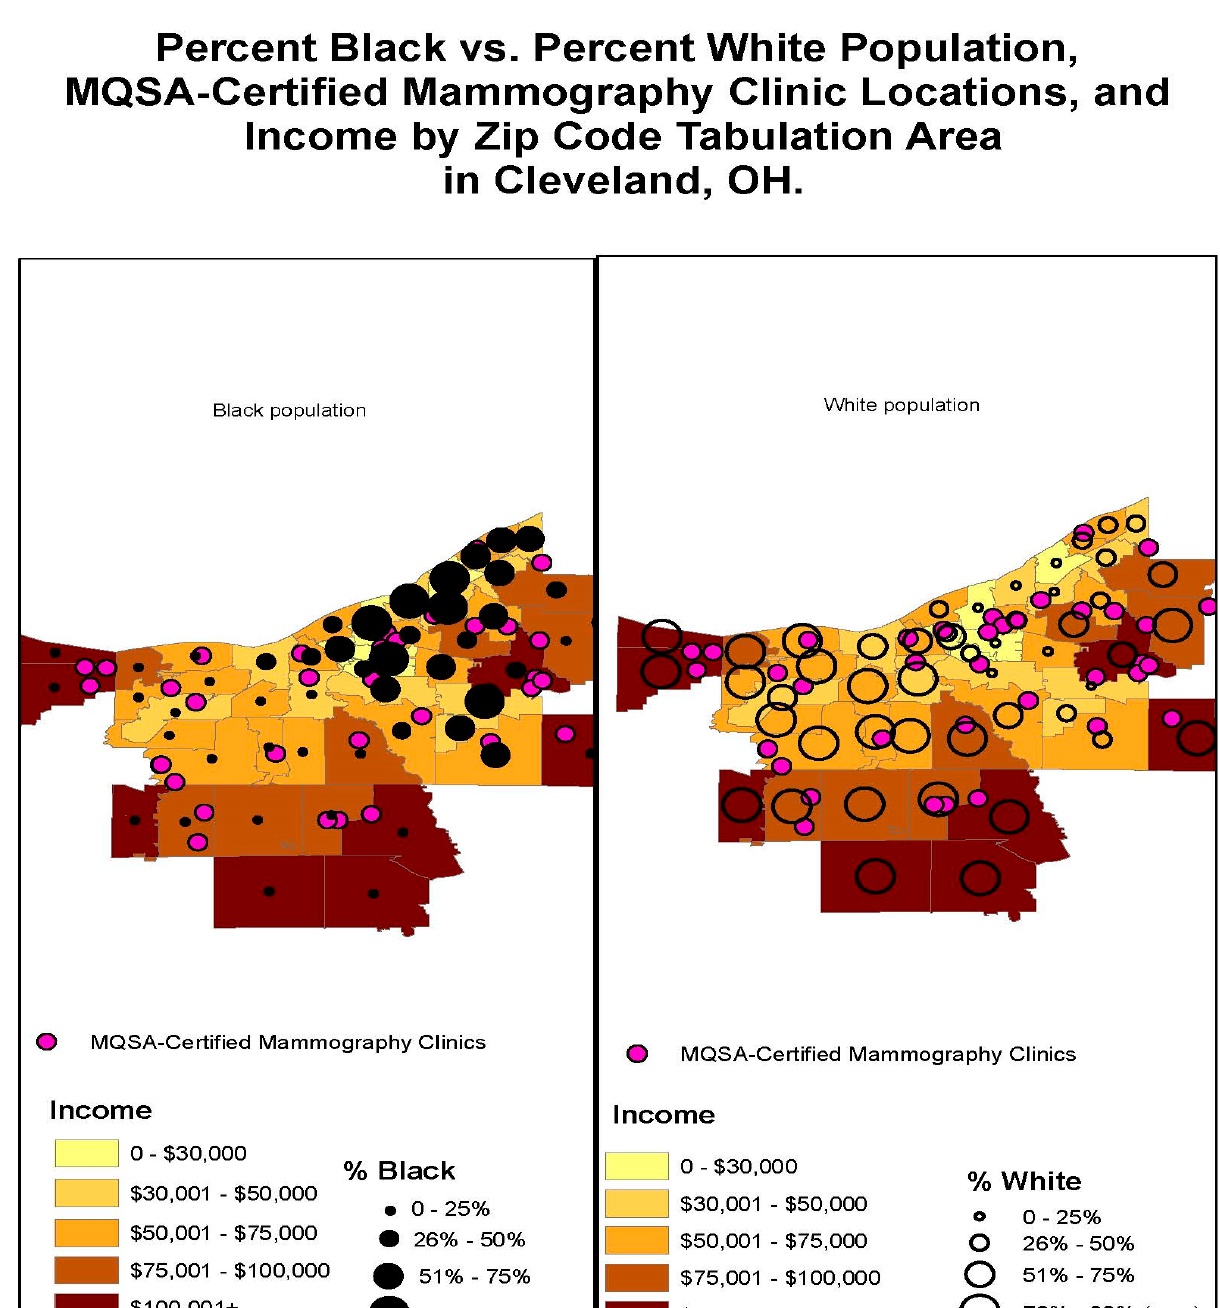
Figure A10. Percent Black vs. Percent White Population, MQSA-Certified Mammography Clinic Locations, and Income by ZIP Code Tabulation Area in Cleveland, OH.